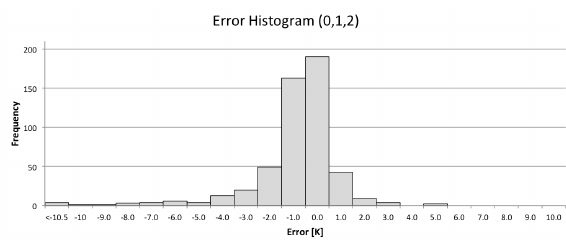
Figure 4: Error histogram for images in cloud categories 0, 1, and 2 in the Landsat 5 validation dataset.